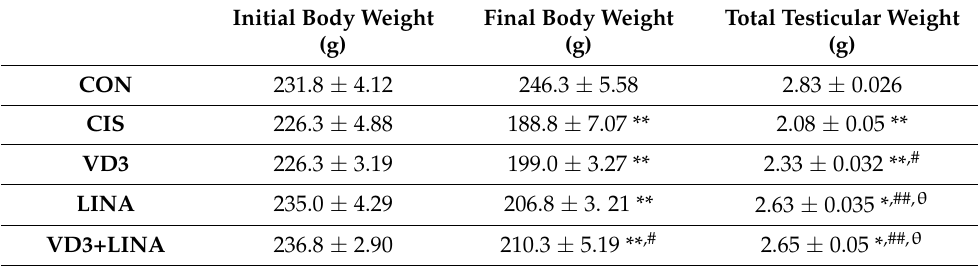
Table 1. Effect of vitamin D3 and/or linagliptin on body and testes weights in cisplatin-treated